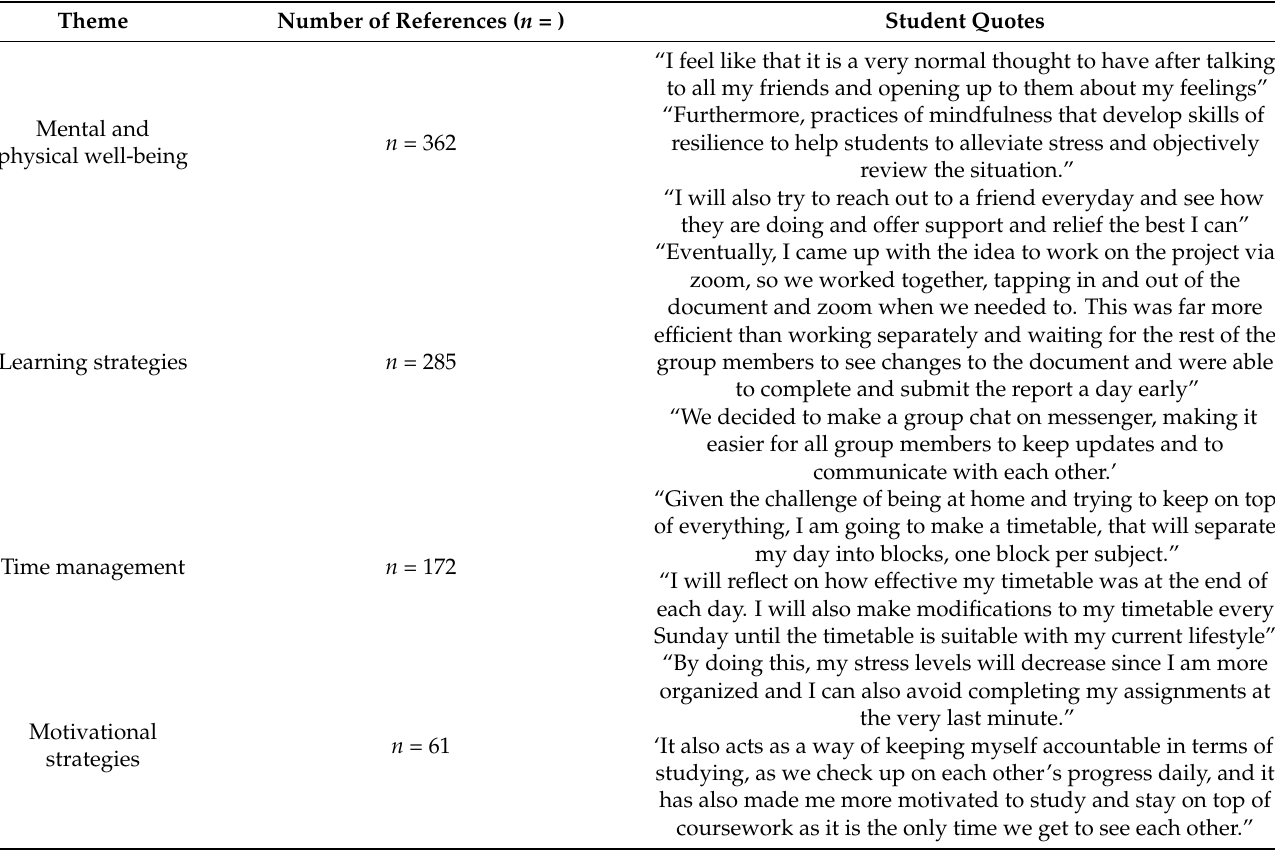
Table 3. The types of strategies that pharmacy students used during initial COVID-19